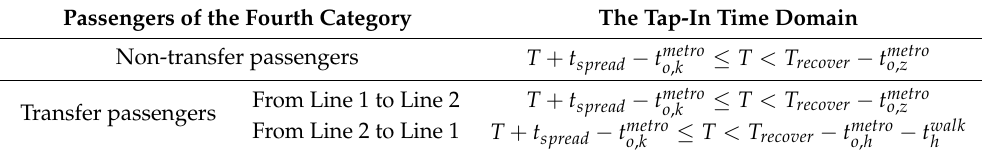
≤ T < T recover − t metro o , z o , k